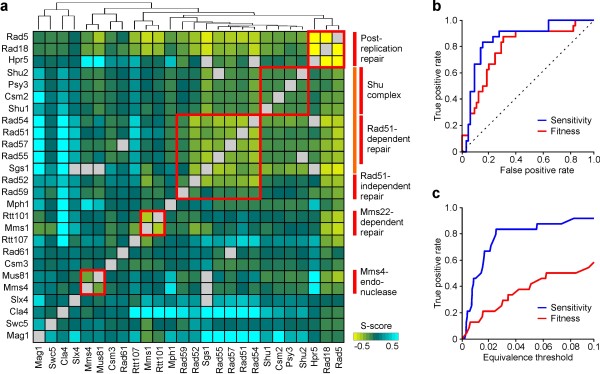
Inference of functional modules and complexes relationships. (a) Hierarchical clustering of S-score profiles. Red bars indicate genes in the Rad5 epistasis group, members of the Shu complex, the Rad51-dependent and independent branches of the Rad52 epistasis group, members of the Mms22-dependent pathway and the Mms4/Mus81 endonuclease complex. The orange bar highlights the clustering of genes in the Shu complex with the Rad51-dependent pathway and Sgs1 (see text for details). Grey squares indicate double mutants not assayed. (b) Comparison of true positive and false positive rates for fitness- and sensitivity-based identification obtained by varying the threshold (Δthr) used to establish equivalence between single- and double-deletion phenotypes (see text). (c) Comparison of true positive rates for fitness- and sensitivity-based identification at different values of the equivalence threshold.